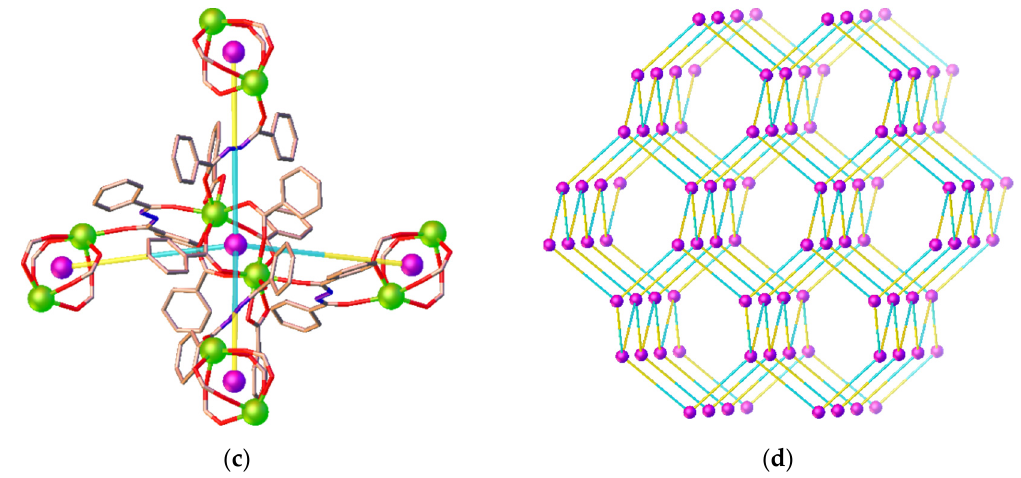
Figure 3. Views of ( a ) the binuclear [Eu 2 (ben) 6 ] SBU, ( b ) the packing arrangements of SBUs along a axis, ( c ) the simplified 4-connected node of the binuclear SBUs and 2-connected node of the ligand, and ( d ) the a 4-connected (6 6 ) dia topology in 2 .